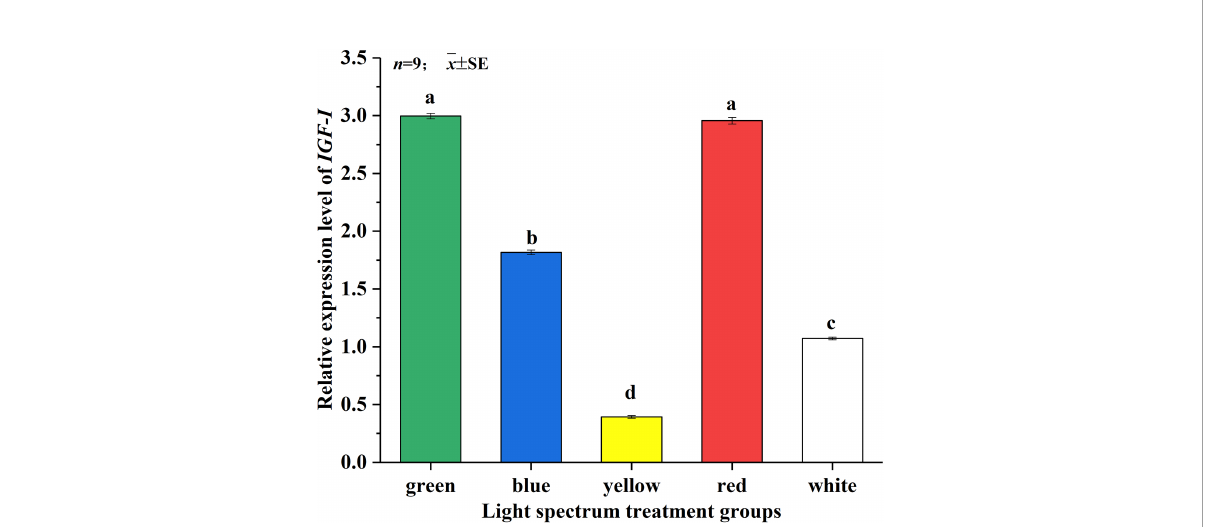
FIGURE 3 Effects of different LED spectra on relative expression of AANAT2 genes in juvenile Takifugu rubripes . In the same column diagram, values with same small letter superscripts mean no signi fi cant differences ( P >0.05), different small letter superscripts mean signi fi cant differences ( P